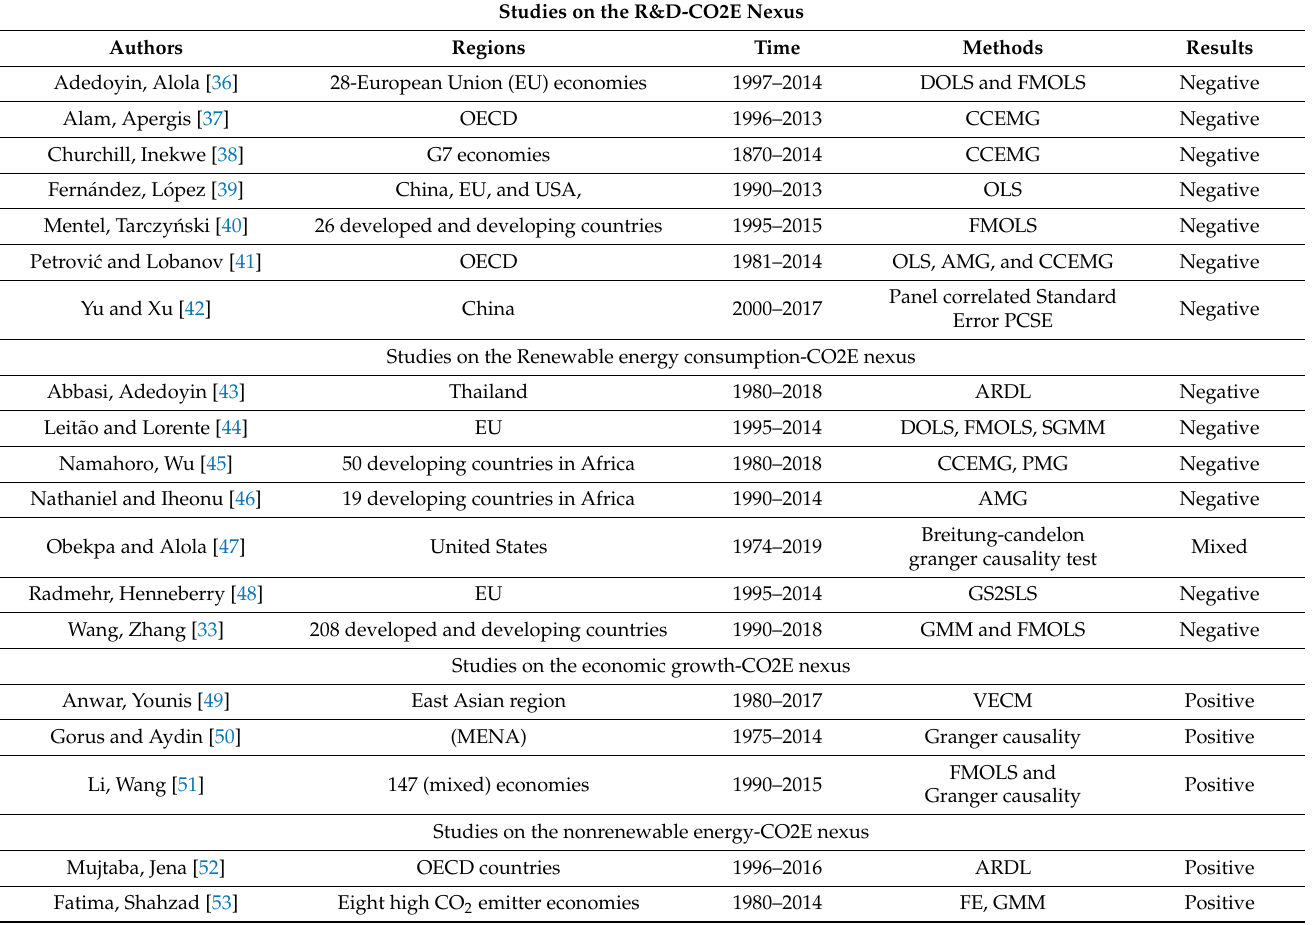
Table 1. Related